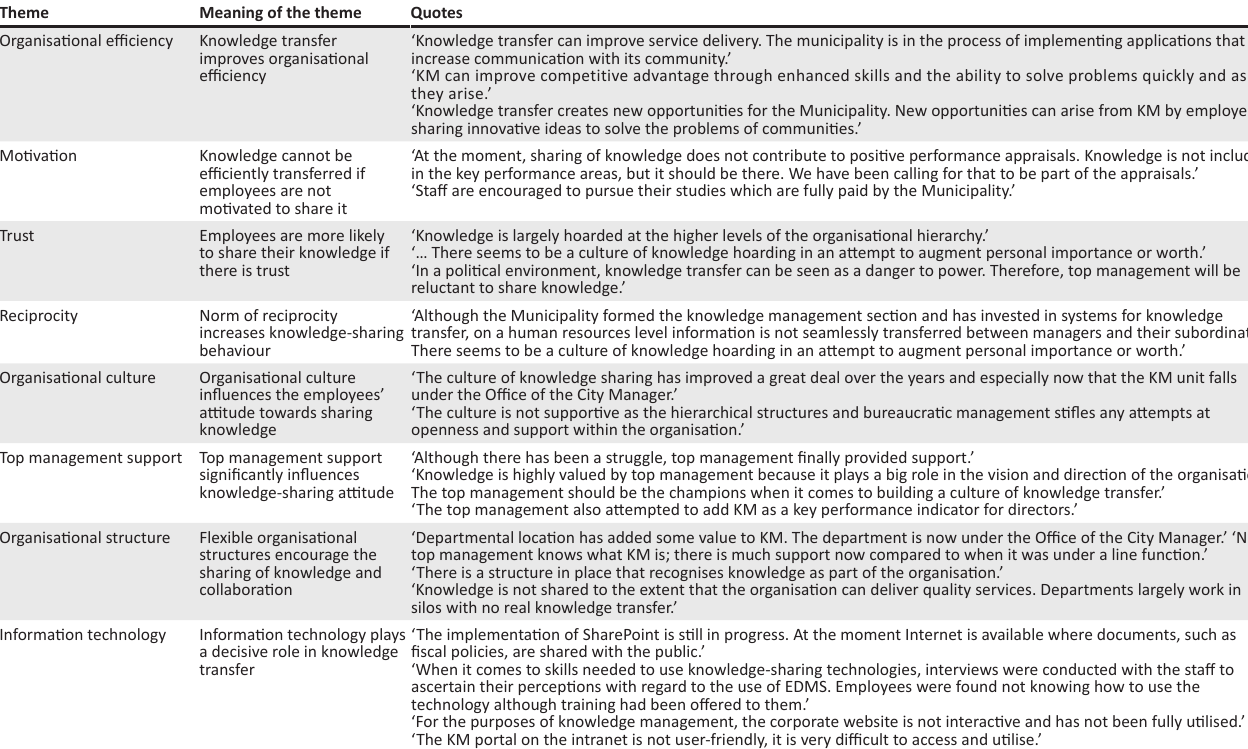
TABLE 1: Example of quotes linked to main